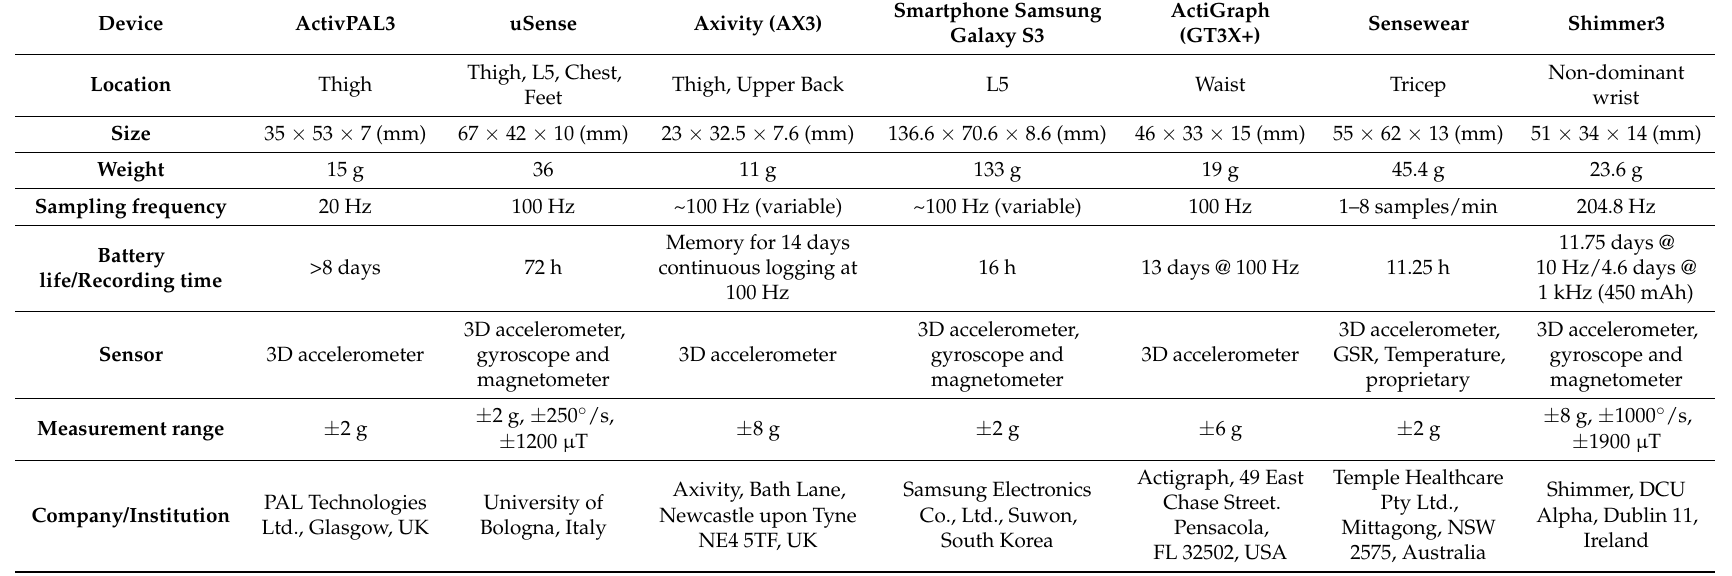
Table 1. List of sensors and devices, attachment locations and